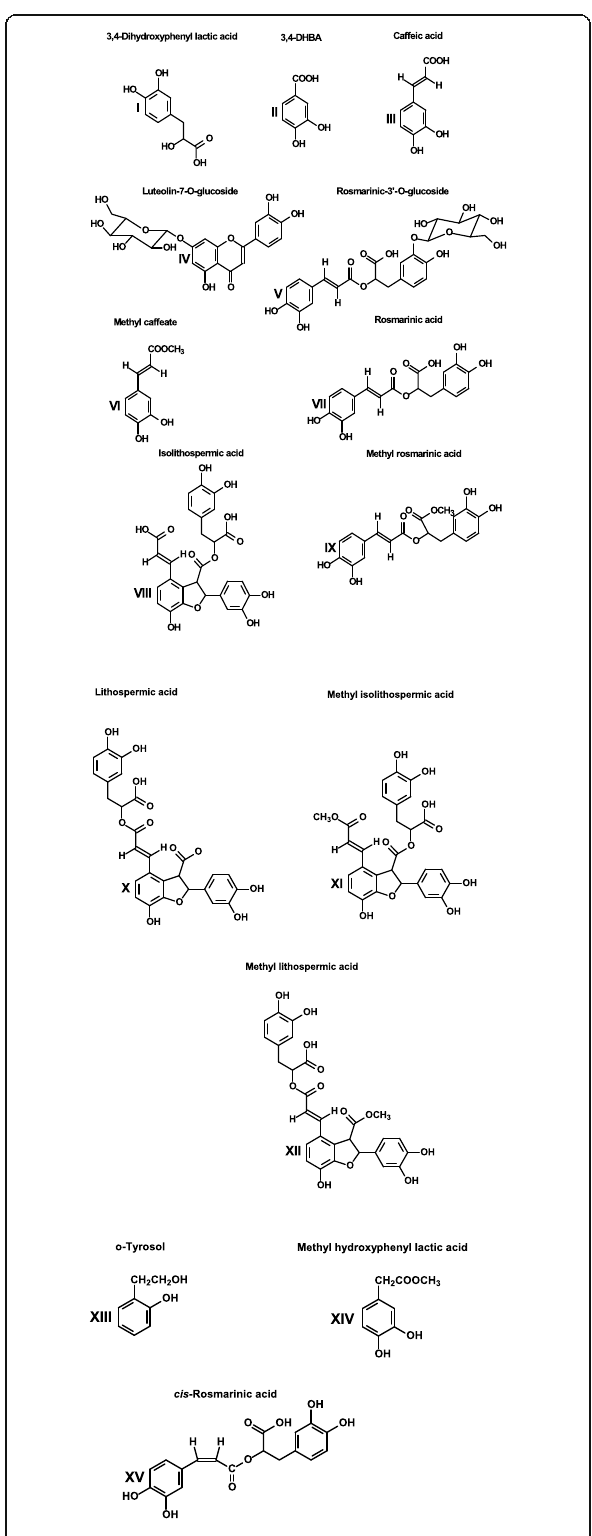
Fig. 4 Structures of the polyphenolic compounds detected in the dichloromethane and ethanol extracts of Melissa officinalis . I 3,4- dihydroxyphenyl lactic acid, II 3,4-dihydroxybenzoic acid, III caffeic acid, IV luteolin-7-O-glucoside, V rosmarinic acid glucoside, VI methyl caffeate, VII rosmarinic acid, VIII isolithospermic acid, IX methyl rosmarinate, X lithospermic acid, XI methyl isolithospermate, XII methyl lithospermate, XIII o-tyrosol, XIV methyl hydroxyphenyl acetic acid, and XV cis-rosmarinic